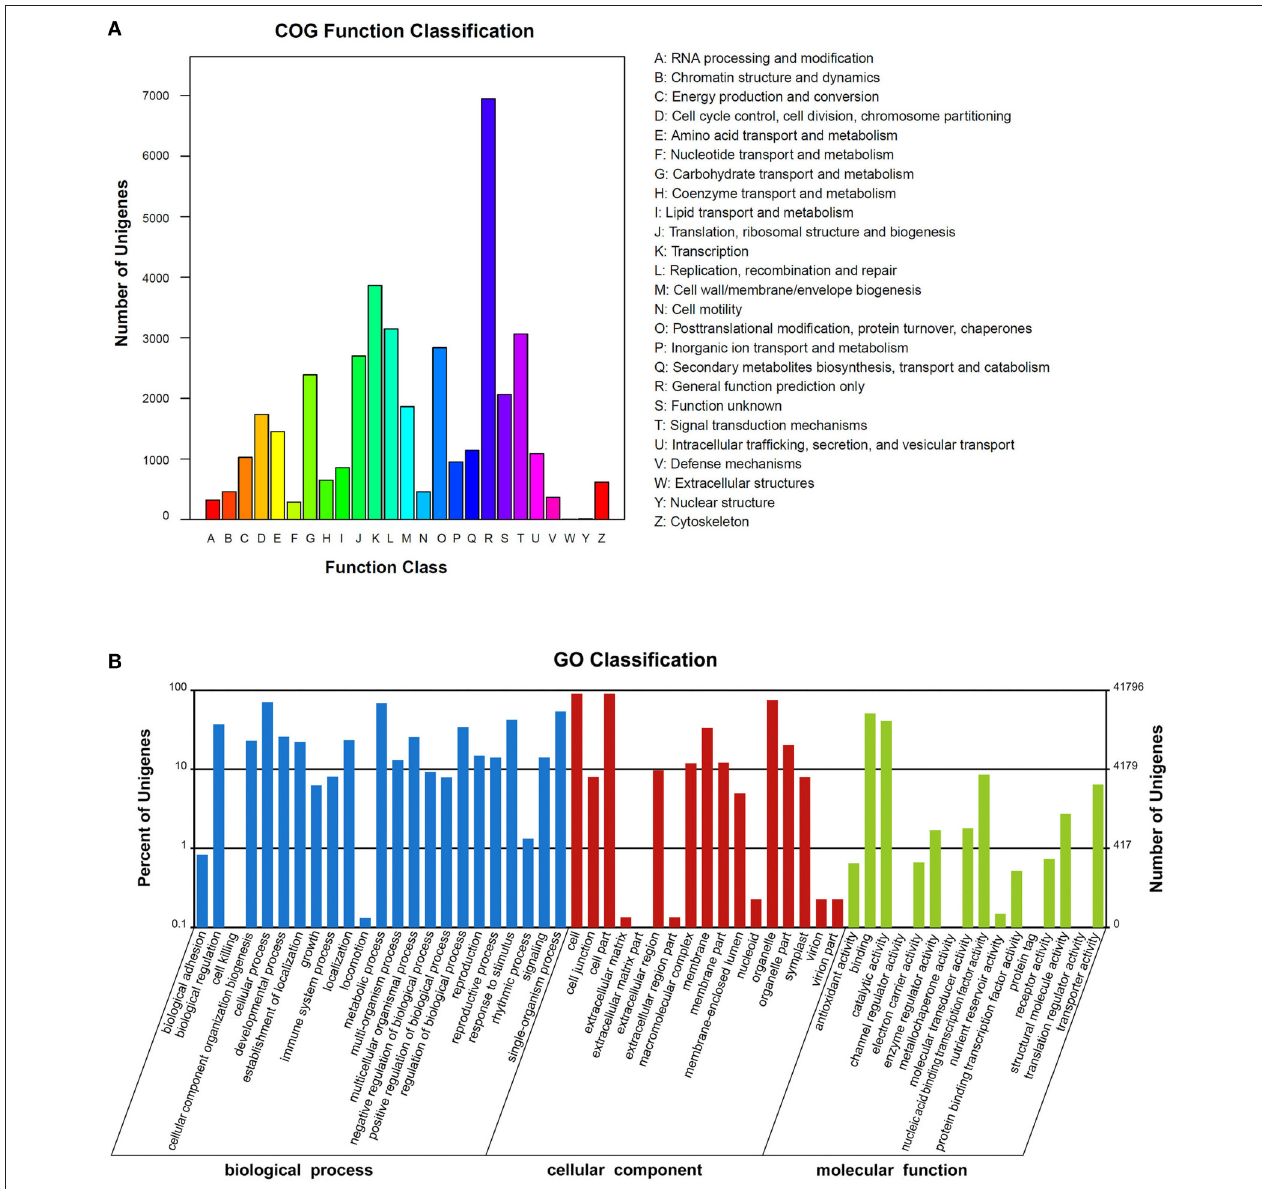
FIGURE 4 | The clusters of unigenes of the Sinapis alba transcriptome. (A) Clusters of Orthologous Groups of proteins (COGs) annotation. (B) Gene Ontology (GO) terms.